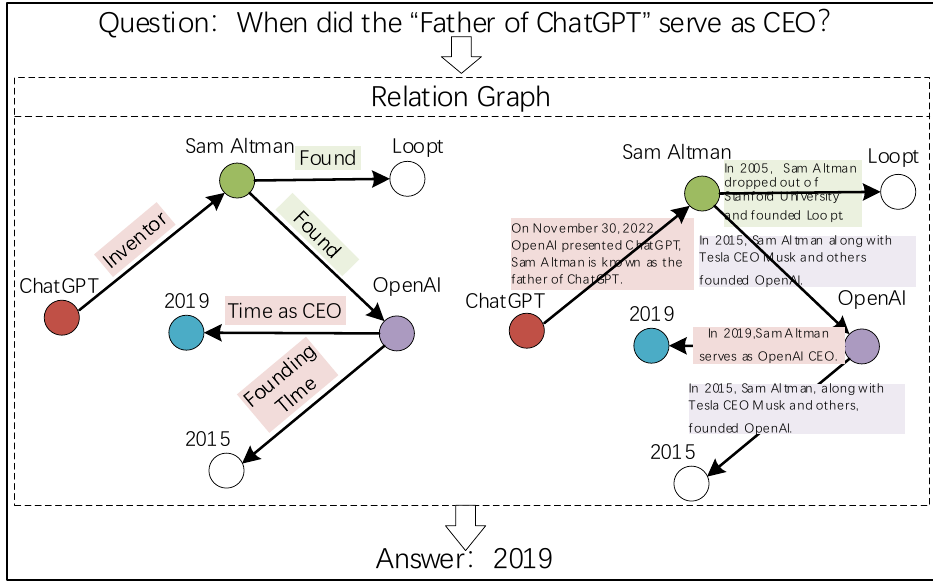
Figure 2. Multi-hop reasoning relation diagram. The relation has label form and text form.